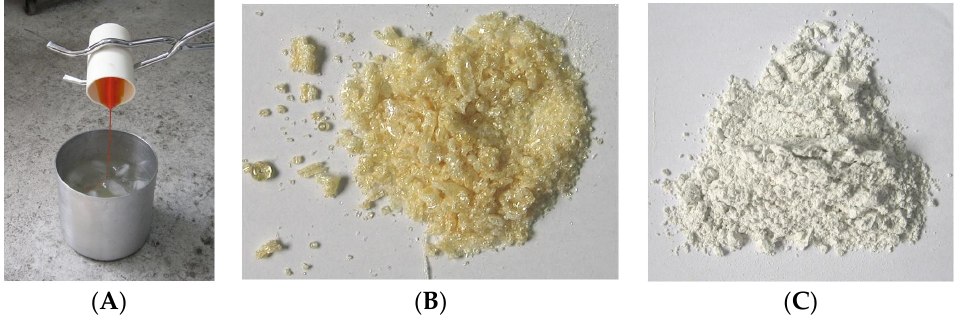
Figure 1. Main steps of frit powder preparation: ( A ) glass mixture cooling in water, ( B ) glass powder after first grinding, ( C ) glass powder after second grinding.